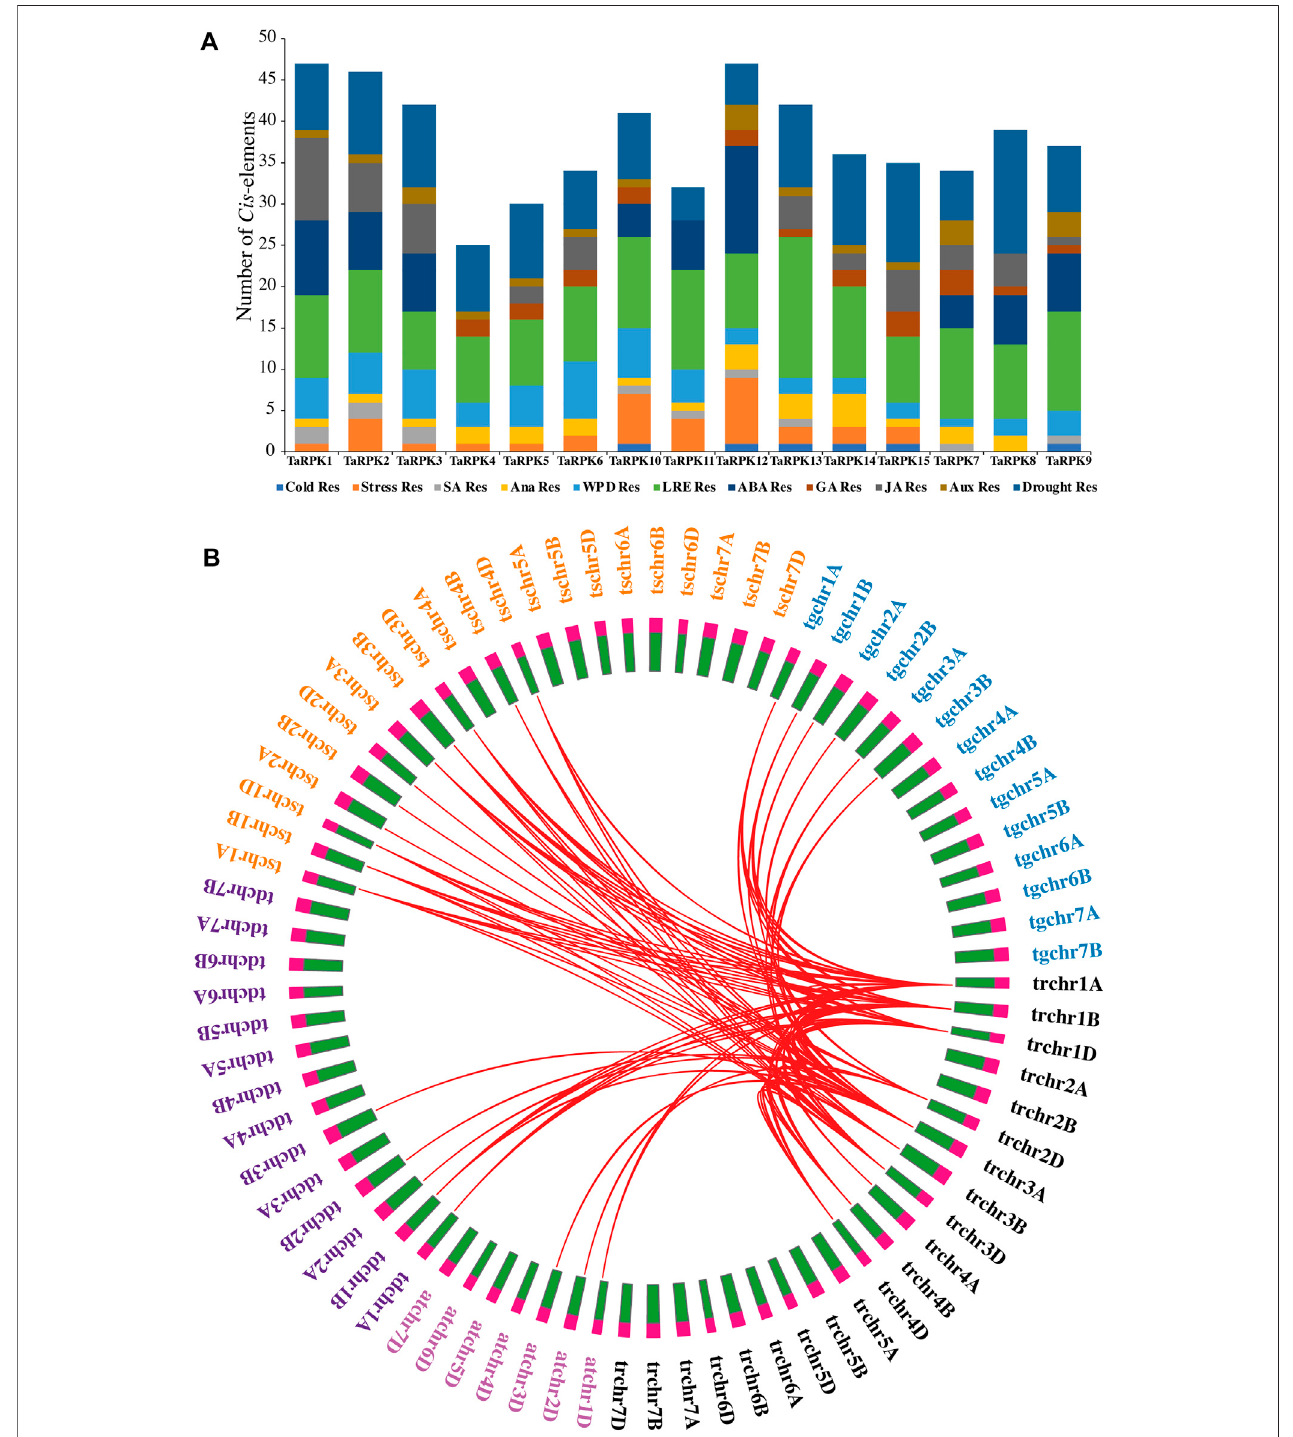
FIGURE 6 | Cis -Elements and evolutionary conservation. (A) Regulatory Cis -element prediction of 2-Kb sequence upstream of RPK1 genes in T. aestivum. (B) Syntenic relationship between Triticum aestivum ( tr, black), Triticum dicoccoides ( td , purple), Triticum turgidum ( tg , blue), Aegilops tauschii ( at, pink), and Triticum speltoides ( ts ,